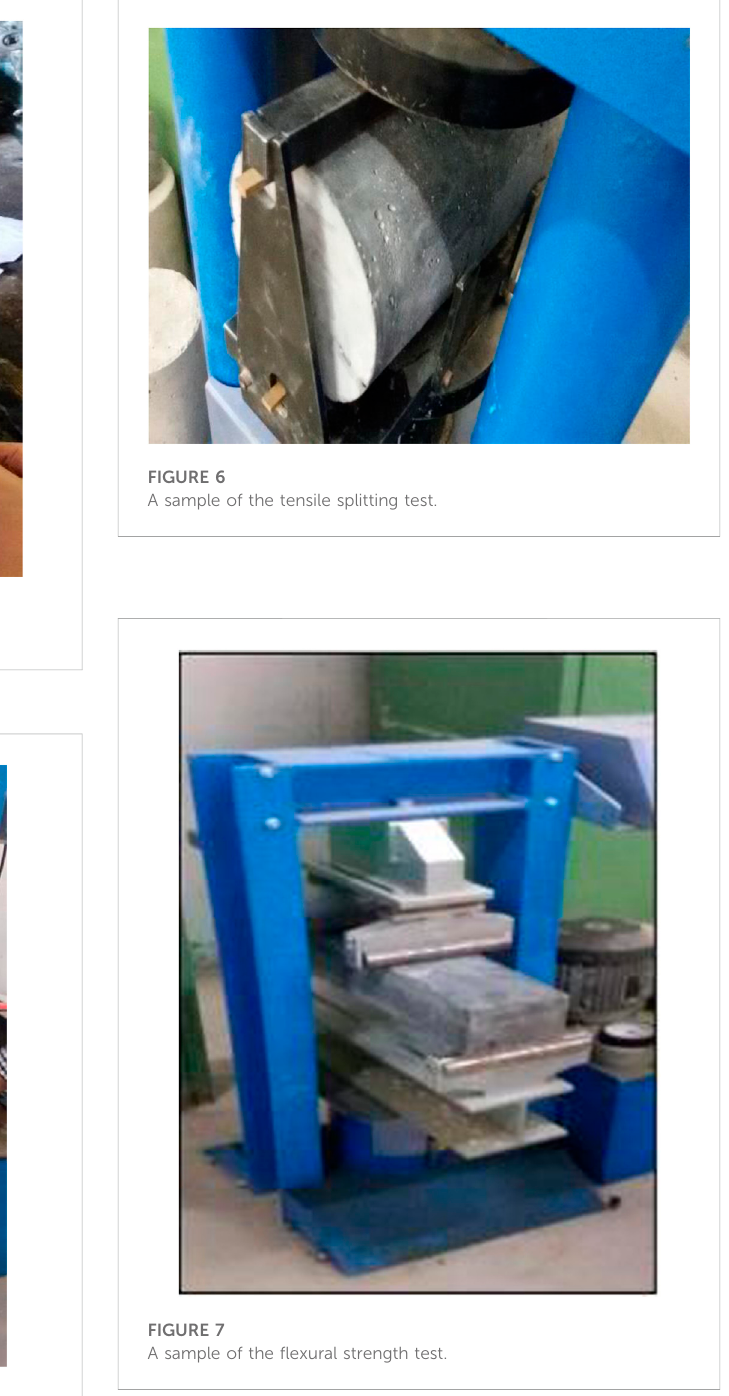
A sample of the fl exural strength